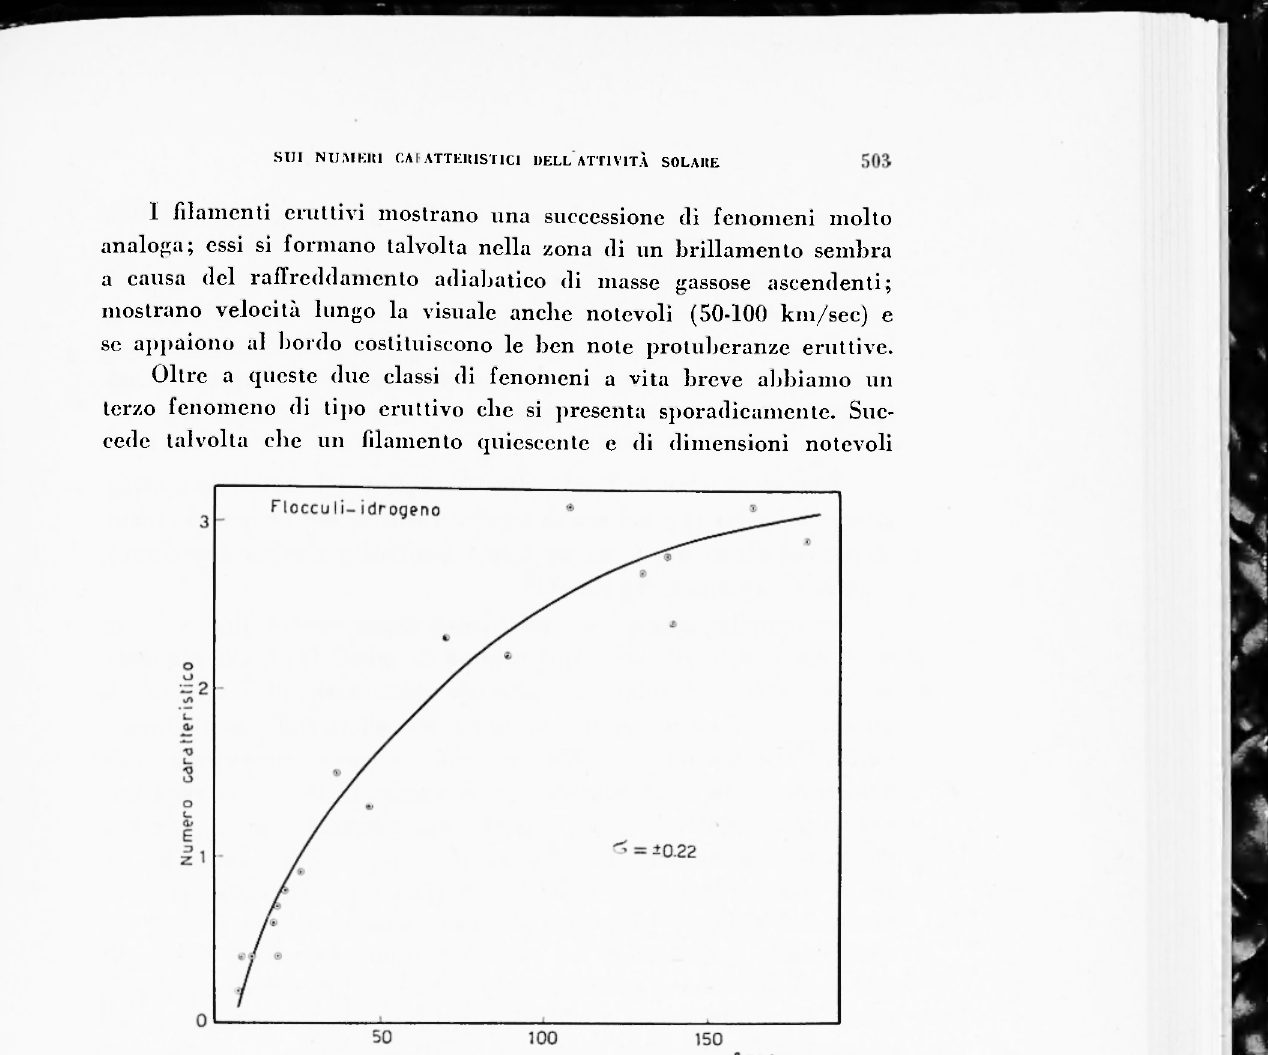
Fig. ] - Variazione del numero caratteristico con